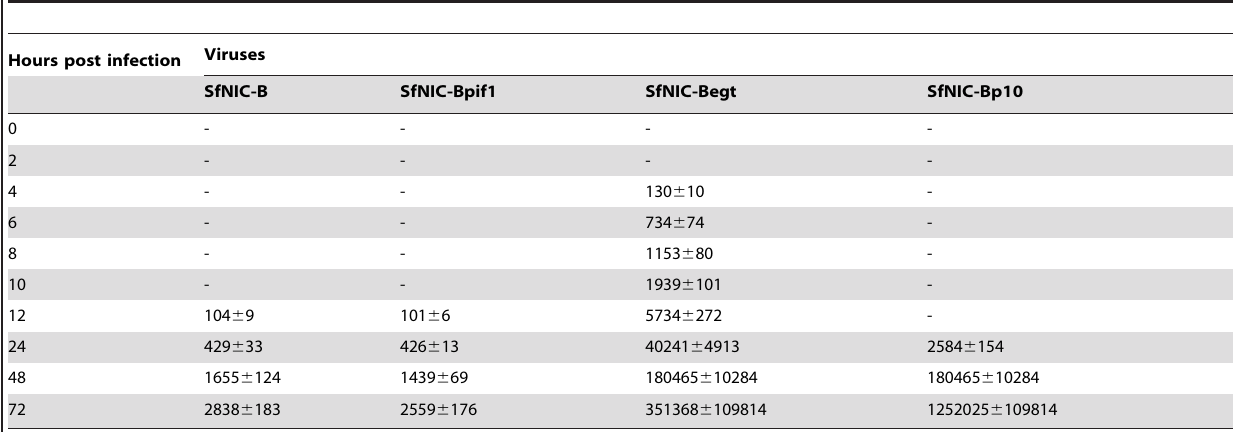
Table 1. Relative expression of pif1 (cDNA copies/ m g RNA) in larvae infected with SfNIC-B and SfNIC-Bpif1 rescue viruses and SfNIC-Begt and SfNIC-Bp10 recombinant